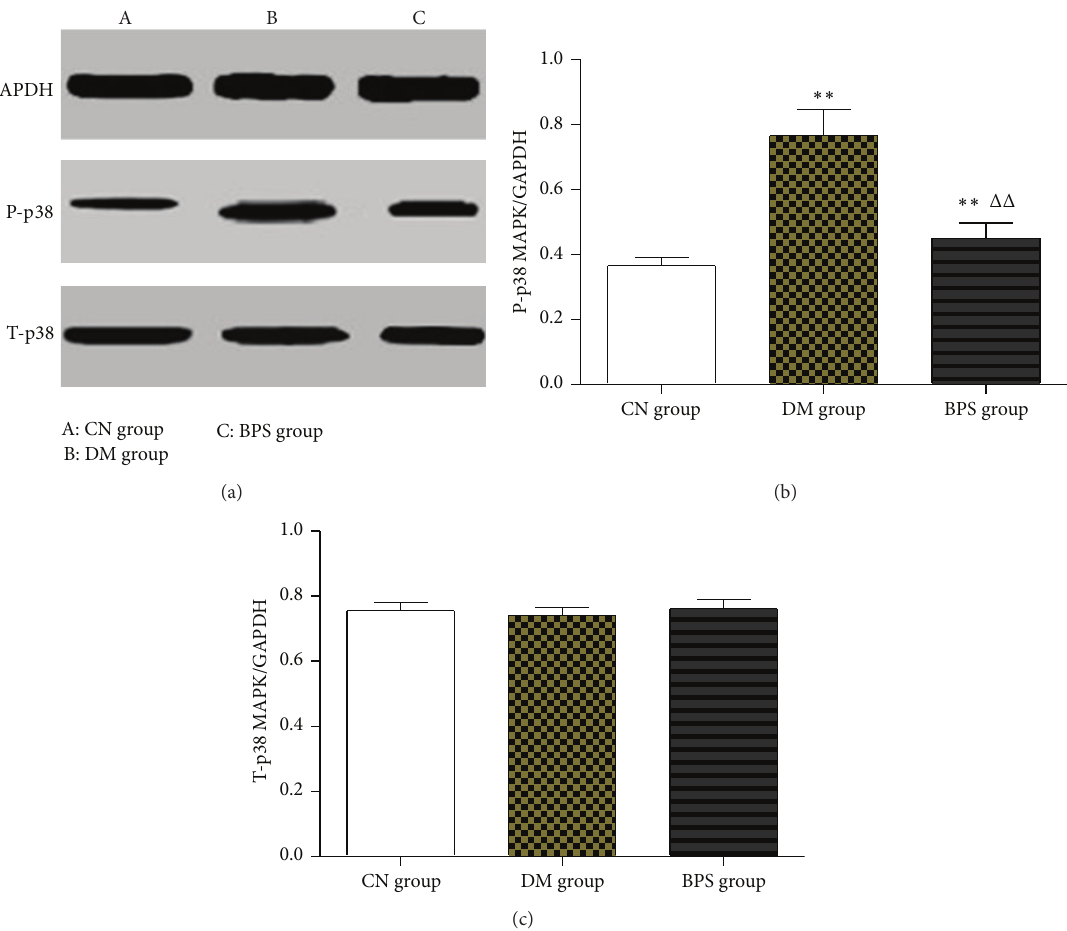
Figure 10: P-p38 MAPK and t-p38 MAPK protein levels in the myocardia. Compared with the CN group, the amount of p-p38 MAPK protein in the DM and BPS groups significantly increased ( 𝑃 < 0.01 ). Compared with the DM group, the amount of p-p38 MAPK protein in the BPS group significantly decreased ( 𝑃 < 0.01 ). Compared with the CN group, the amount of t-p38 MAPK protein in the DM and BPS groups did not significantly change ( 𝑃 > 0.05